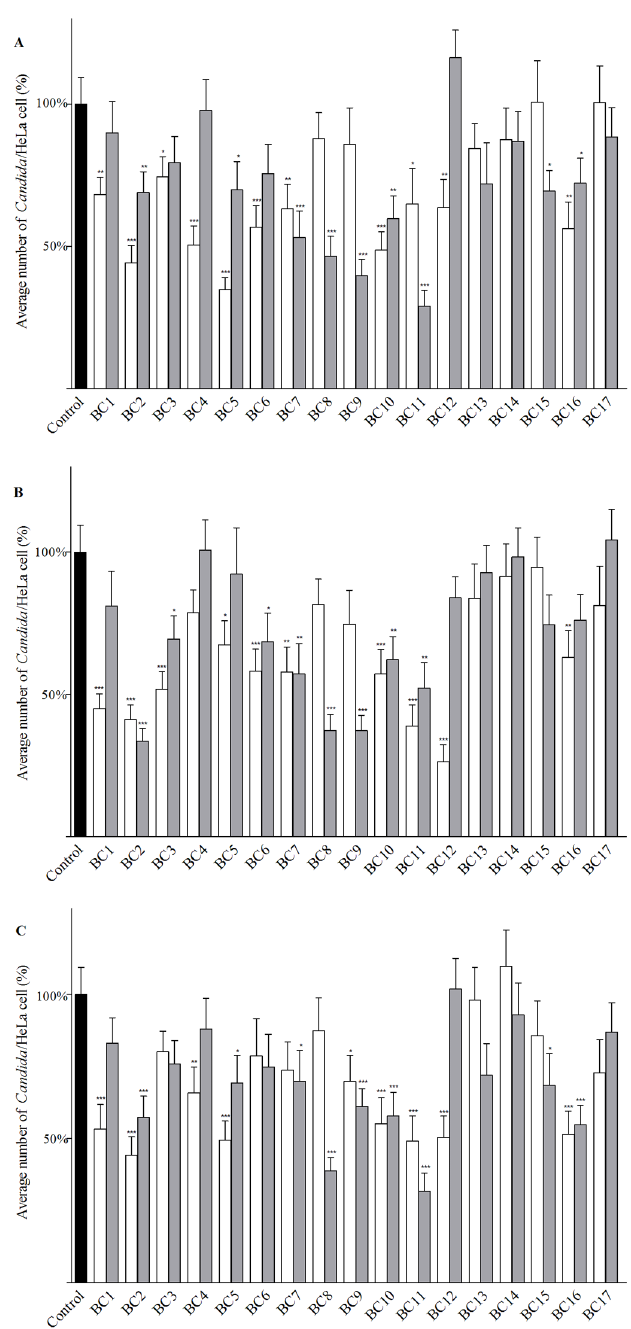
Fig 3. Interference of vaginal lactobacilli with C . albicans adhesion to HeLa cells. Exclusion (A), competition (B) and displacement (C) experiments were performed. The results were expresses as percentages of adherent yeasts per HeLa cell and compared with adhesion without lactobacilli (control value). The control value was taken as 100% of adhesion (black bars). White and grey bars show the adhesion of C . albicans in presence of Lactobacillus cells and supernatants, respectively. Statistical significance was determined at P < 0.05 * , P < 0.01 ** and P < 0.001 *** . Error bars represent SEM.